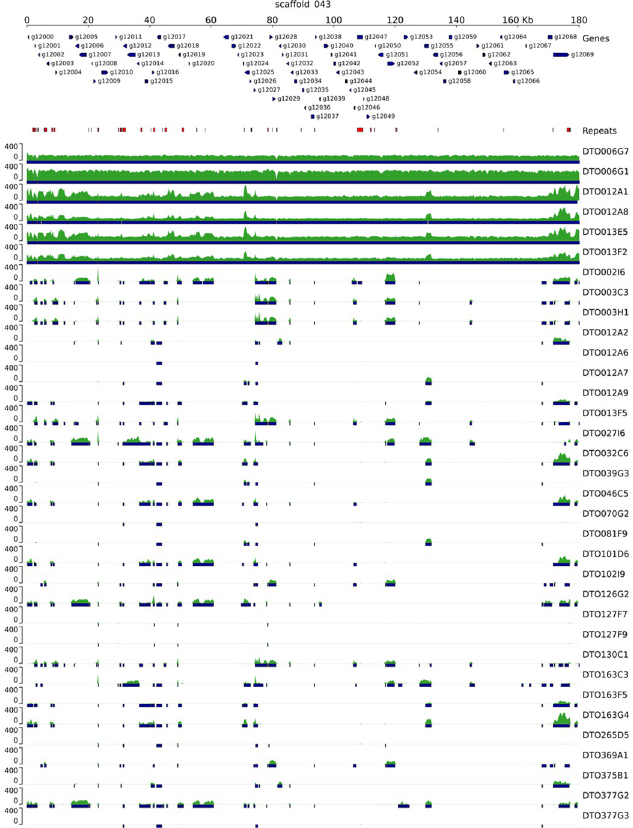
Fig 4. Genome comparison reveals unique gene cluster in R-type strains. Genomic alignment of 33 P . roqueforti strains to the SORBUS cluster (scaffold 43 of DTO006G7). Predicted genes are indicated with arrows, repetitive DNA is indicated in red, the sequence read coverage is indicated in the green tracks, and blue bars indicate (partial) overlap with DTO006G7. The complete SORBUS cluster is only present in the R-type strains (DTO006G1, DTO006G7, DTO012A2, DTO012A8, DTO013F2 and DTO013E5).